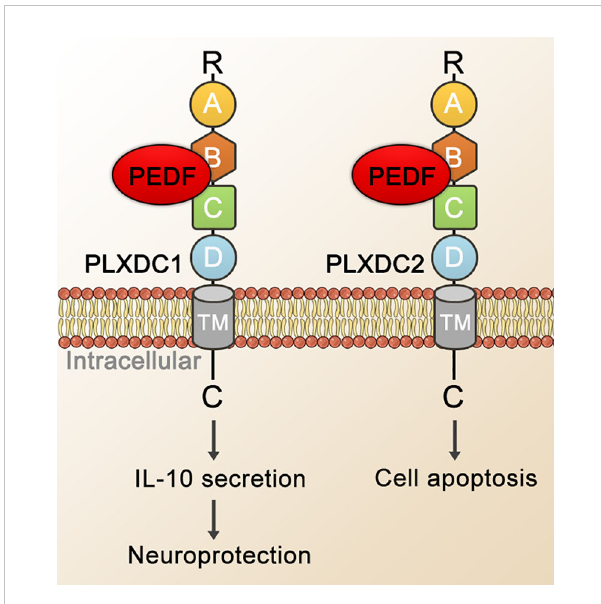
FIGURE 3 Schematic representation of PEDF-activated PLXDC1 or PLXDC2 signaling. PEDF binds to the cell-surface homologous membrane proteins PLXDC1 and PLXDC2 through their extracellular domains. Domain B plays an important role in binding PEDF. The TM and the C-terminus of these receptors mediate downstream signaling. Ultimately, this signal transduction mechanism stimulates the PLXDC1-dependent secretion of IL-10, which exerts neuroprotective and apoptosis-promoting effects in combination with PLXDC2. TM, transmembrane domain; IL-10,